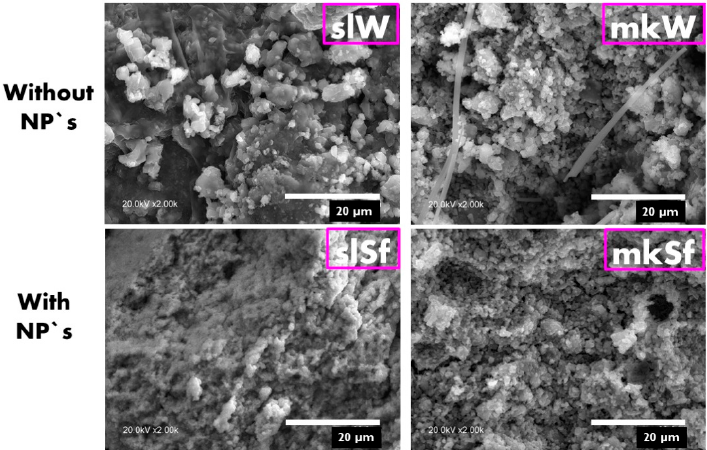
Figure 3. SEM images of the metallurgical slag (SL) and metakaolin (MK) pastes without and with nanoparticles.